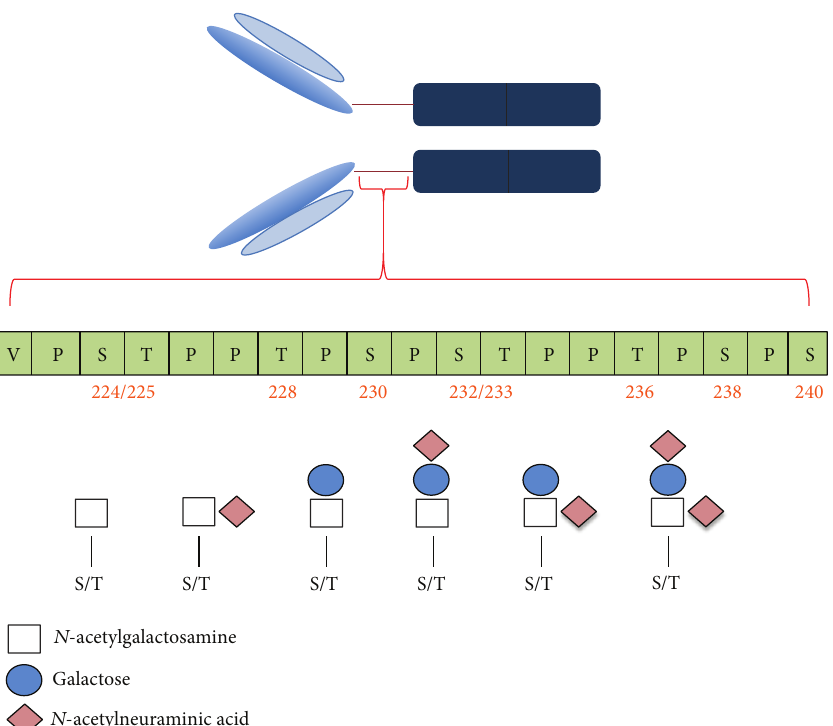
Figure 1: IgA1 and hinge-region O -glycosylation in IgAN patients. Figure of monomeric IgA1, with the hinge-region amino-acid sequence below to show the S/T residues that are O -glycosylated (numbered in red). Three to six core 1 O -glycans are attached per hinge region, with N -acetylgalactosamine (white square) being the first sugar added; galactose (blue circle) may be then attached. Both glycans may be sialylated by N -acetylneuraminic acid (pink diamond), attached to N -acetylgalactosamine in an 𝛼 2,6 linkage and to galactose in an 𝛼 2,3 linkage. Patients with IgAN have elevated levels of circulatory IgA1 with some galactose-deficient O -glycans, consisting of terminal or sialylated N